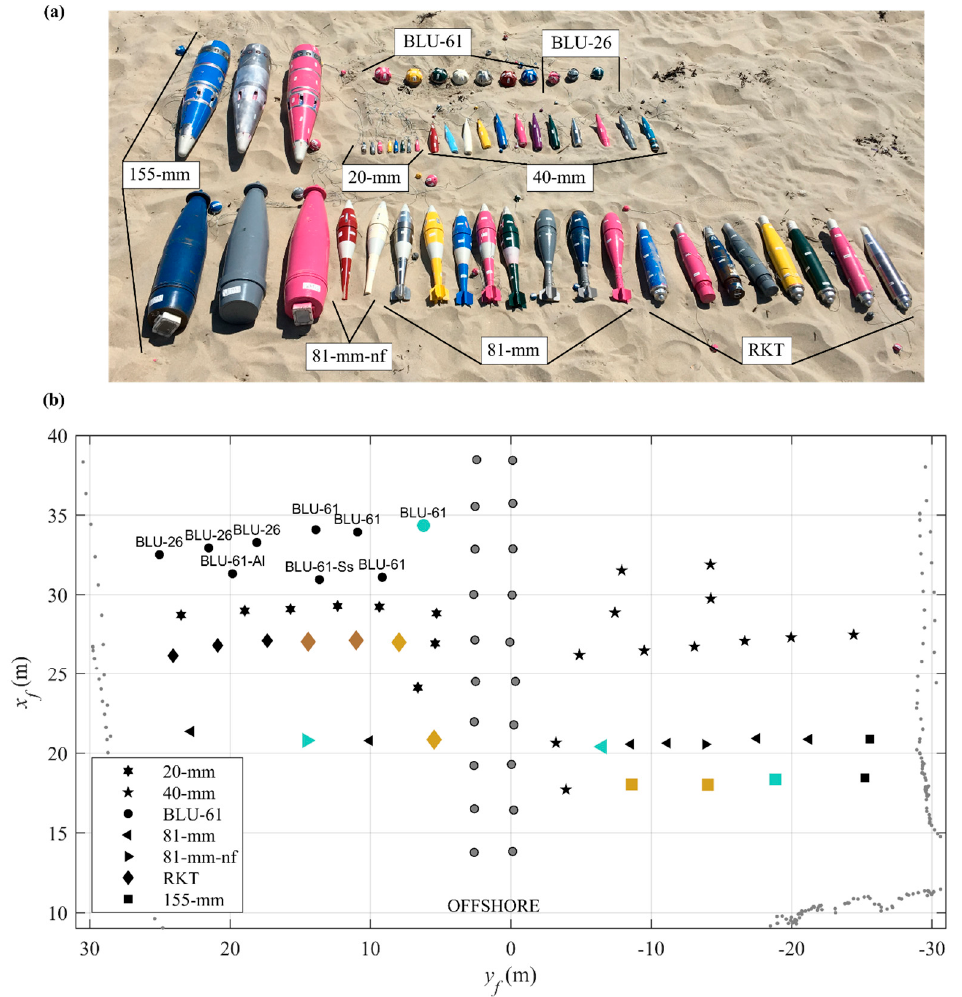
Figure 12. ( a ) Munition variety used during the study for both long term and force analysis munitions. ( b ) Long term munition initial deployment. Color-coding is related to munition instrumentation, brown = PT; turquoise = IMU; gold = IMU and PT and black = not instrumented.